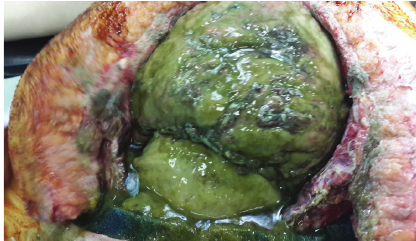
Figure 6: Proximal and distal part of perforation point on jejunum are seen.